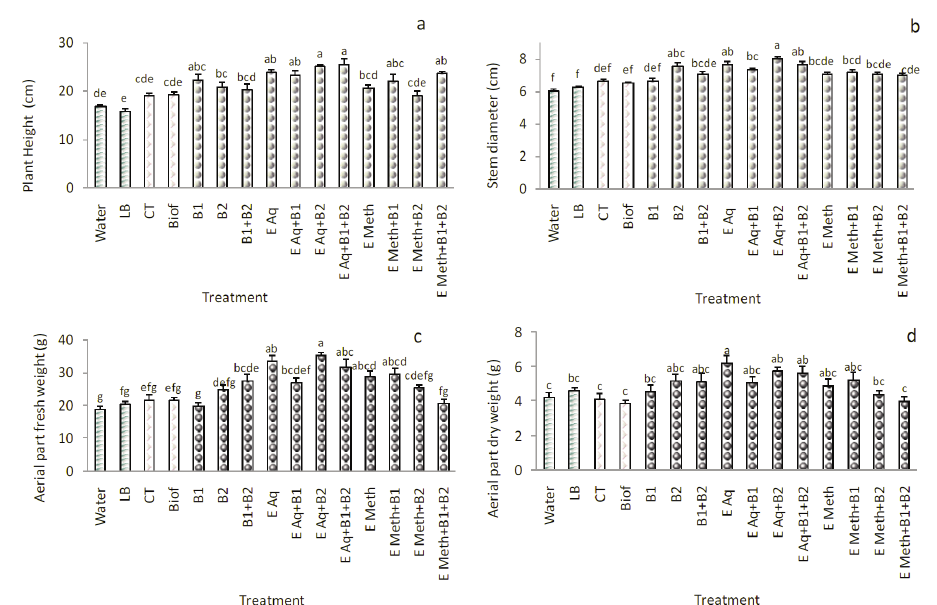
Fig. 1 ­ Comparative efficacy of single and combined bio­treatments with Sargassum vulgare extracts and selected Bacillus spp. strains on the aerial part development of eggplant plants compared to the untreated control and to two organic amendments. Water= Plants treated with water; LB= Plants treated with Luria­Bertani broth medium; CT= Plants treated with a compost tea; Biof= Plants treated with a commercial bio­fertilizer (Acadian™); B1= Single treatment with B. subtilis SV41; B2= Single treatment with B. amyloliquefaciens subsp. plantarum SV65; B1+B2= Combined treatment with B. subtilis SV41 and B. amyloliquefaciens subsp. plantarum SV65; E Aq: Single treatment with aqueous S. vulgare extract; E Aq+B1= Combined treatment with S. vulgare aqueous extract and B. subtilis SV41; E Aq+B2= Combined treatment with aqueous S. vulgare extract and B. amyloliquefaciens subsp. plan‐ tarum SV65; E Aq+B1+B2= Combined treatment with aqueous S. vulgare extract and both Bacillus spp. strains. E Meth= Single treatment with methanolic S. vulgare extract. E Meth+B1= Combined treatment with methanolic S. vulgare extract and B. subtilis SV41; E Meth+B2: Combined treatment with methanolic S. vulgare extract and B. amyloliquefaciens subsp. plantarum SV65; E Meth+B1+B2: Combined treatment with methanolic S. vulgare extract and both Bacillus spp. strains. Bars sharing the same let­ ters are not significantly different according to Multiple Range Duncan test at 5%. (a) Comparative efficacy of tested bio­treat­ ments on eggplant height; (b) Comparative efficacy of tested bio­treatments on eggplant stem diameter; (c) Comparative efficacy of tested bio­treatments on eggplant aerial part fresh weight; (d) Comparative efficacy of tested bio­treatments on eggplant aerial part dry